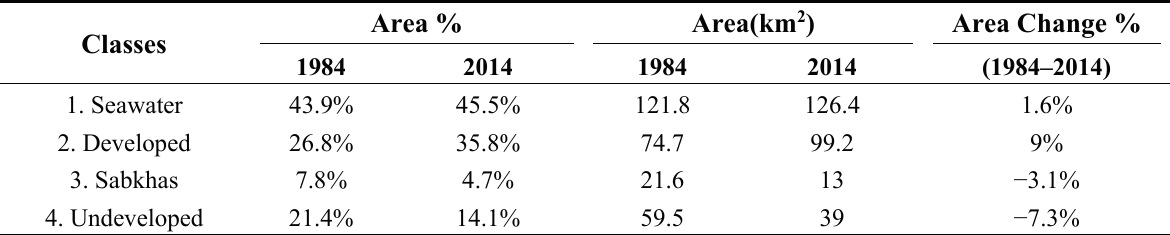
Figure 5. Landuse supervised-classification for the different Landsat images 1984, and 2014. Table 2. Area and percentage of change of different land cover classes of 1984 and 2014 classified